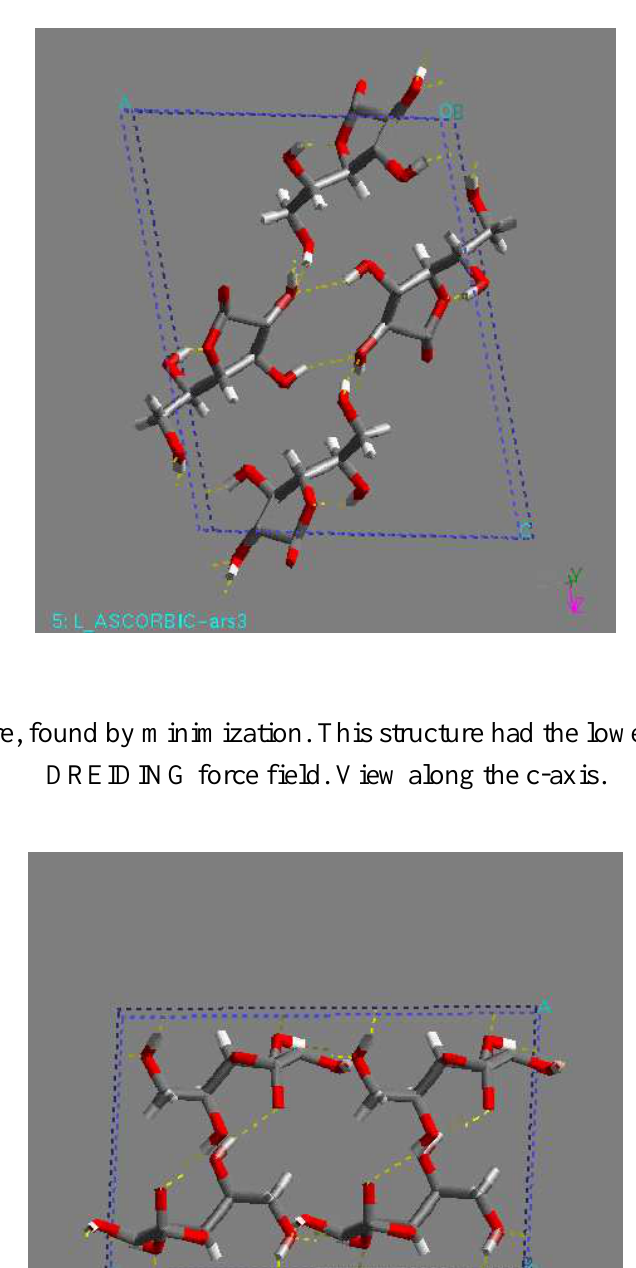
Figure 3. P2/c structure, found by minimization. This structure had the lowest lattice energy in the DREIDING force field. View along the c-axis.